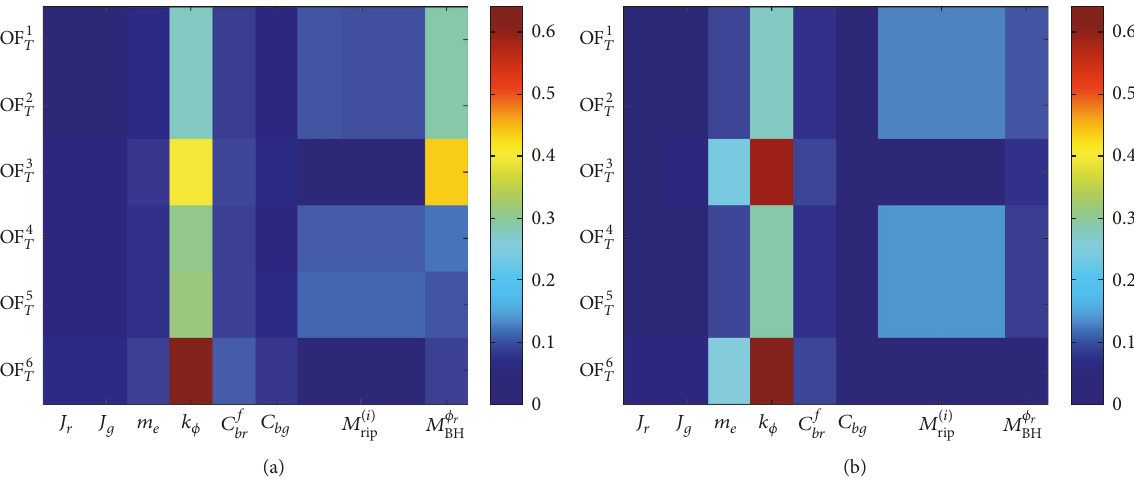
Figure 16: Primary sensitivity 𝑆 𝑖 (a) and total sensitivity ST 𝑖 (b) indices for torsional model for OS 1 with no backlash.